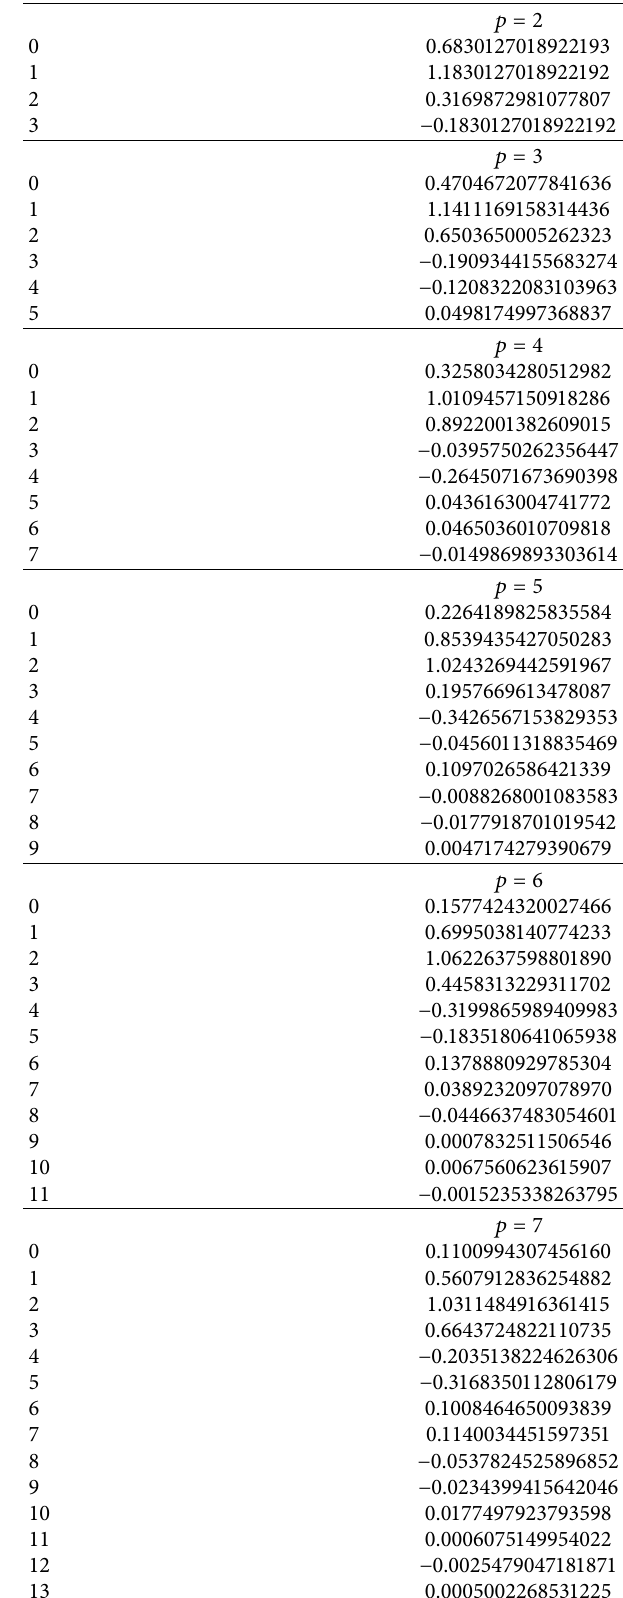
Table 1: Filter coefficients of the Daubechies scaling